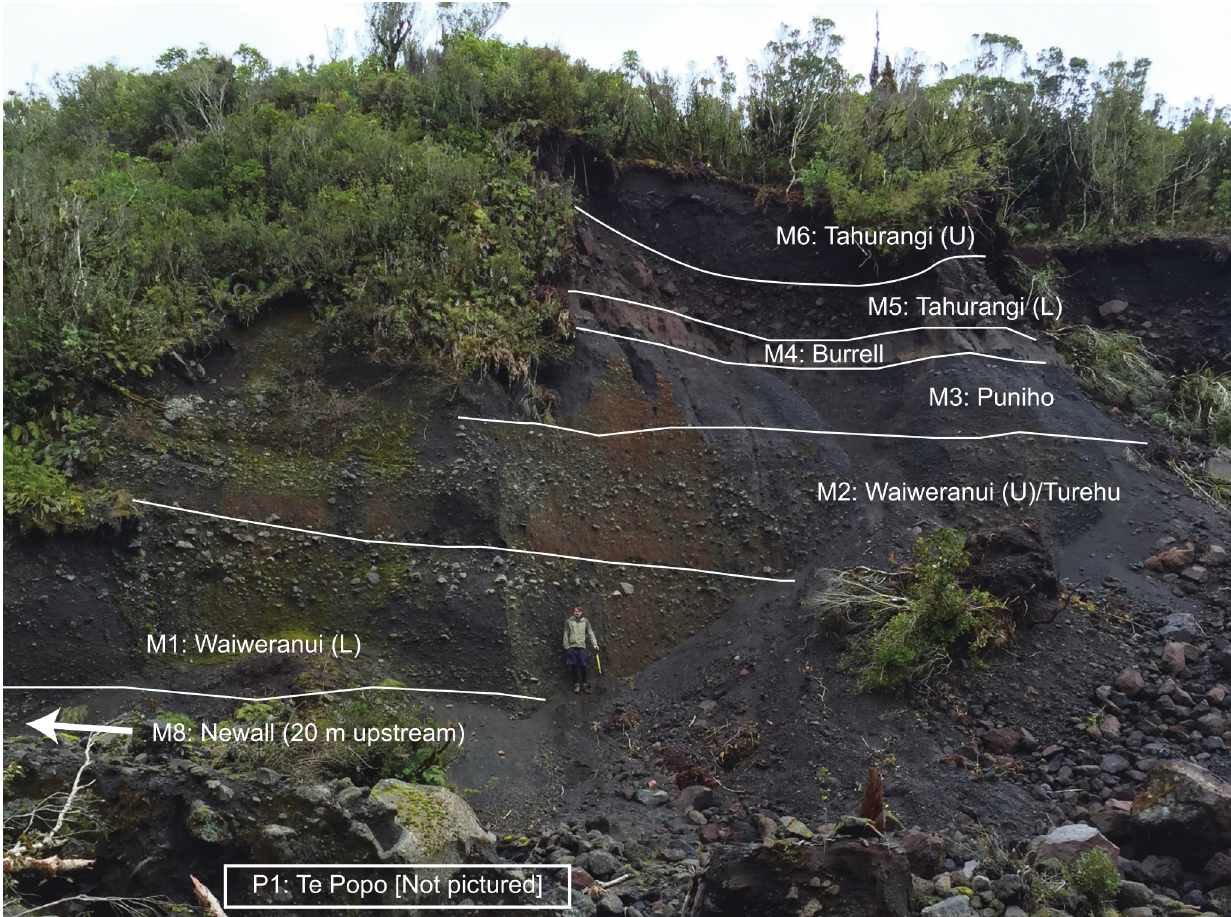
Figure 3: Annotated photograph of the type section of the Maero Formation in the Maero stream, showing units sampled in this study. Site M8 (Newall unit) was sampled 20 m upstream on the same river bank as this photo. P1 (Te Popo) is not pictured; it was sampled at a separate location in the Pyramid stream. those below by a weak soil, is a < 40 cm weakly strati- fied deposit. These units consist almost exclusively of grey to black andesite. Above the Turehu, the Puniho unit (M3) is an up to 1 m-thick, matrix supported de- posit containing primarily lapilli-sized clasts. The Bur- rell unit (M4, present in the type section but not